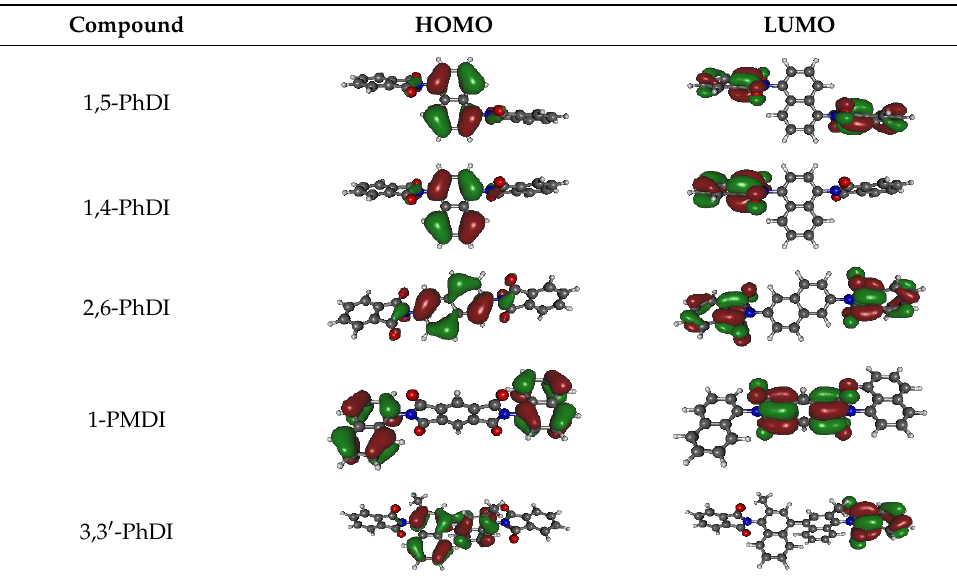
Table 7. Calculated HOMO and LUMO orbitals of investigated compounds.